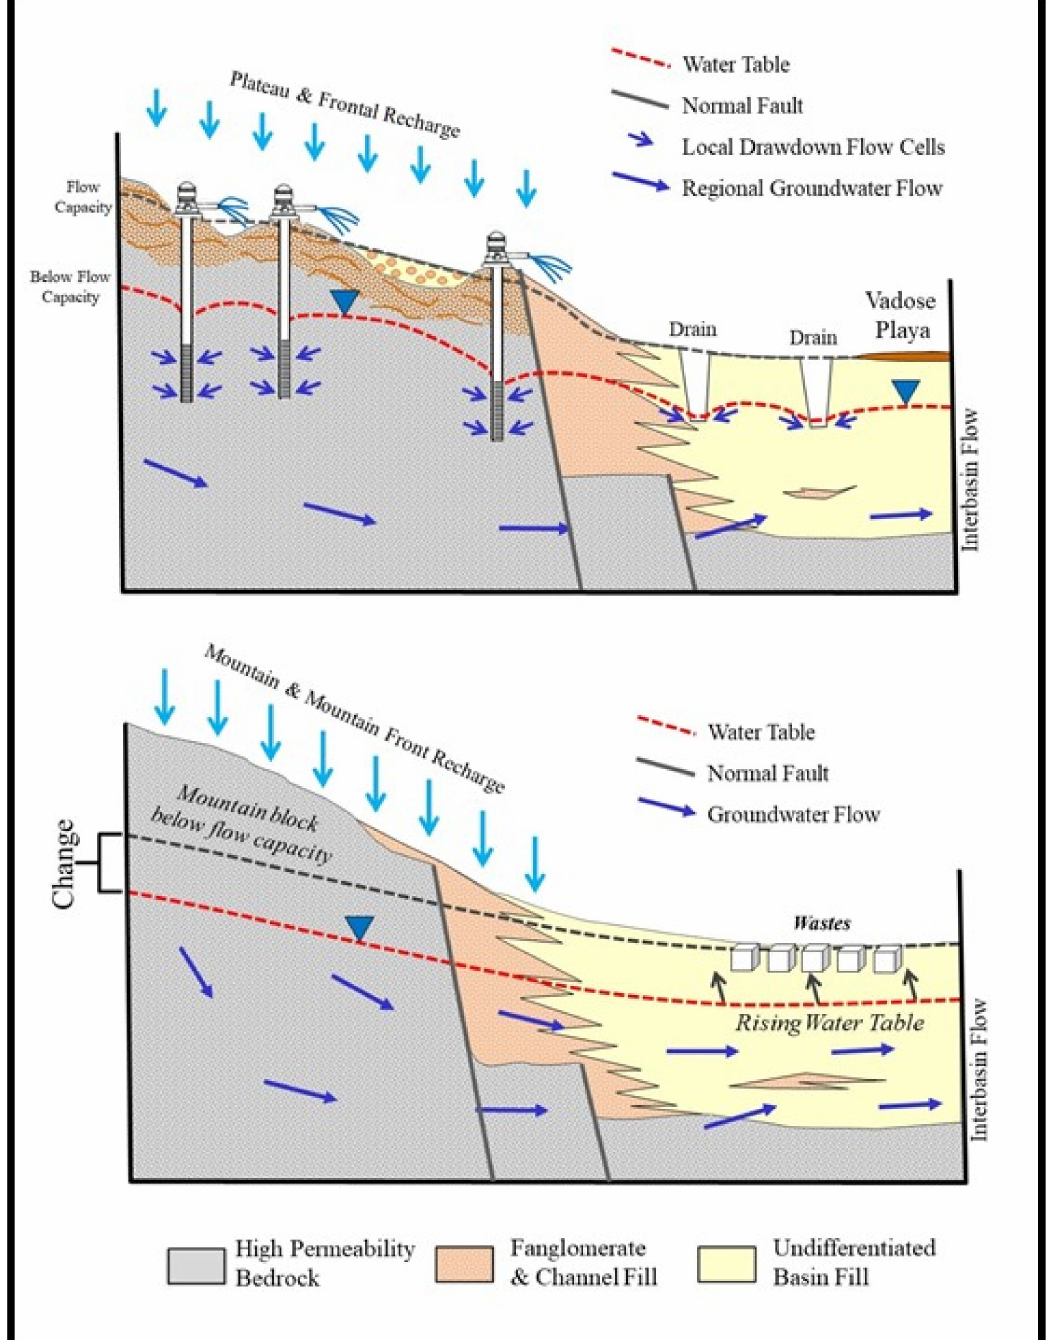
Figure 5. Upper figure, aquifer development can convert a groundwater basin and highlands from flow capacity to non-capacity. Lower figure, buried wastes may be a threat to aquifers used for waste disposal if the aquifer achieves flow capacity due to climate